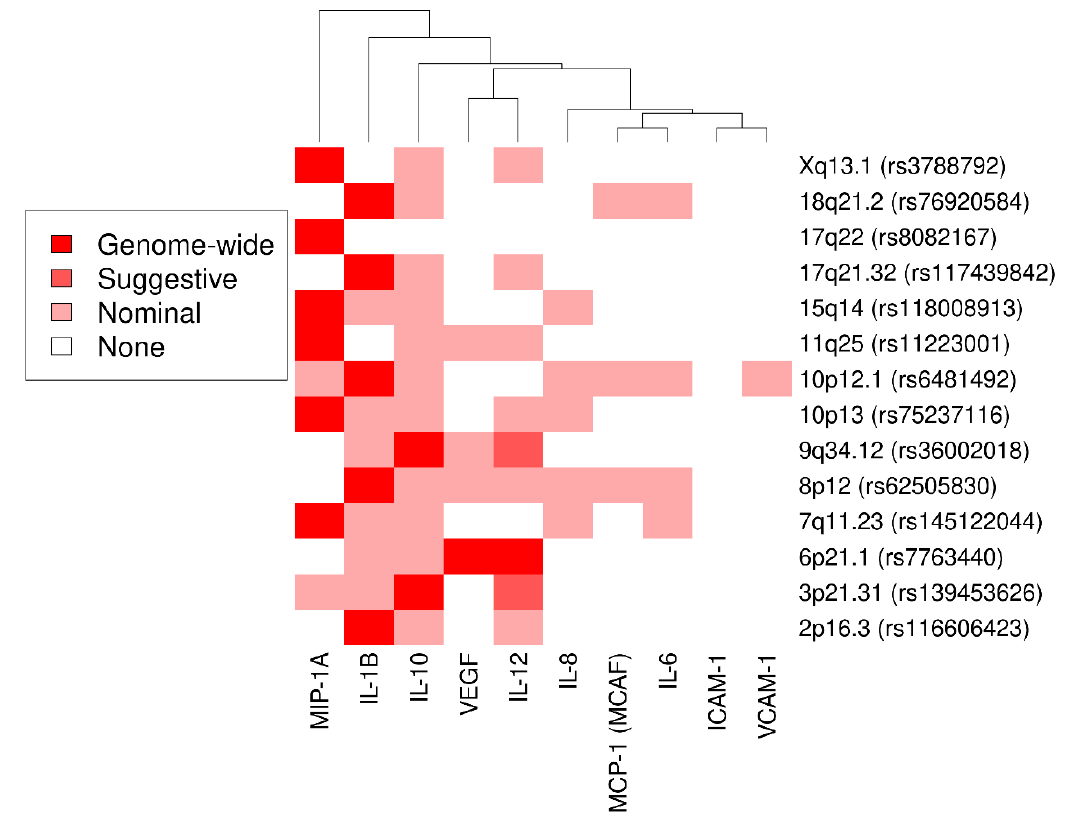
Figure 2. Cluster heatmap for associations between the lead SNPs of the 14 loci and the 10 cytokines of interest. Strength of association is indicated by color intensity. Cytokines are ordered by hierarchical clustering according to p -value similarity.